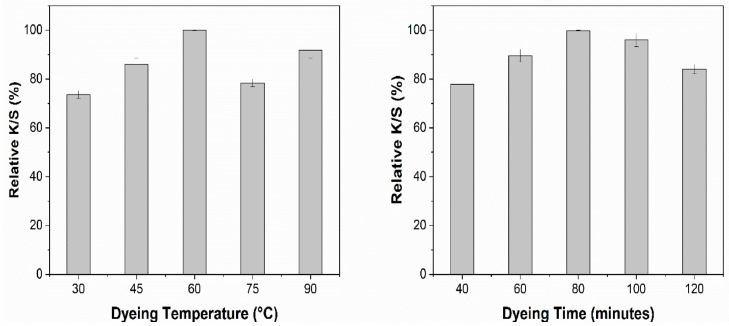
Figure 9. Effect of dyeing conditions on the relative K/S obtained with EtOH